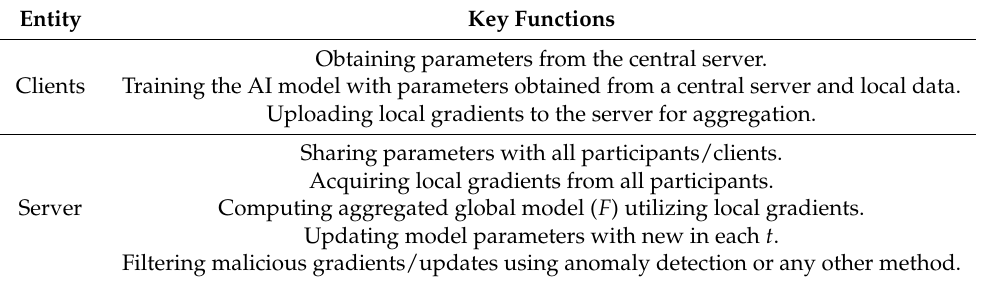
Table 1. Functions/activities performed by clients and server in the FL paradigm.